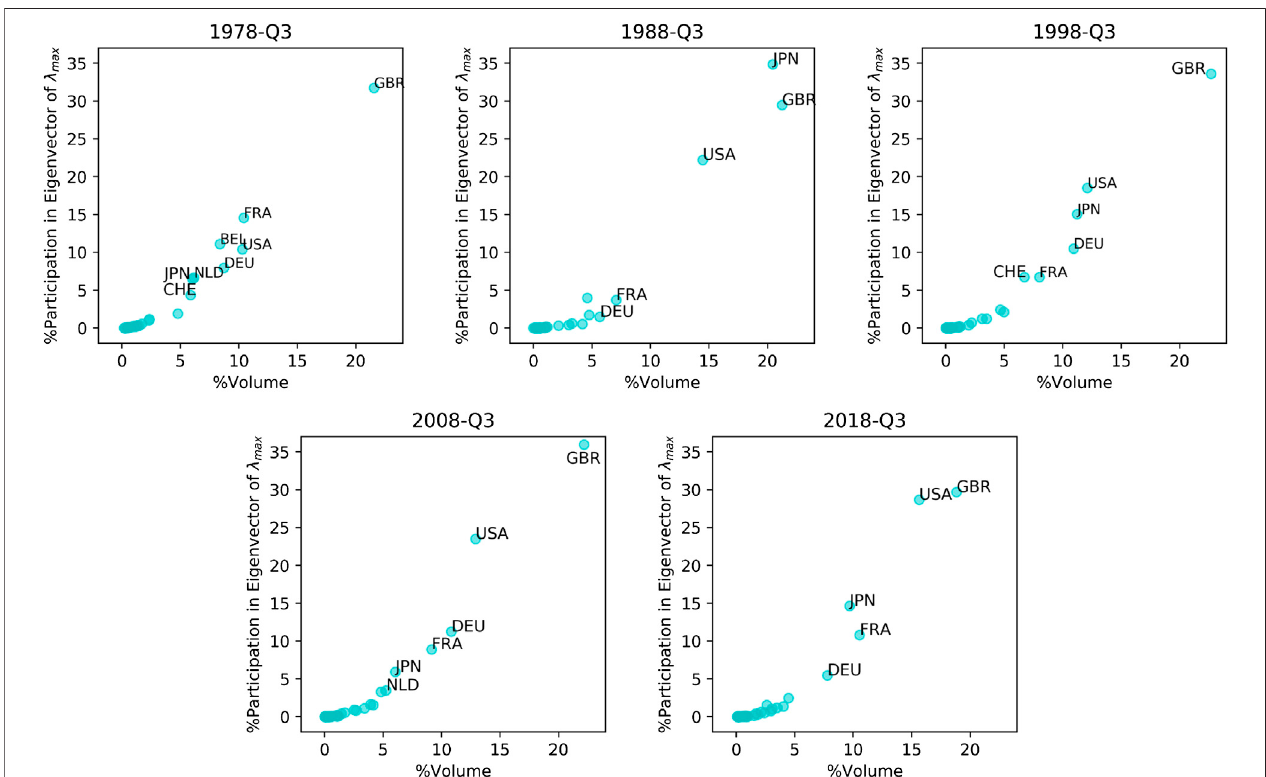
FIGURE 5 | The percentage of the participation of each country in the eigenvector of λ max vs. the percentage of the transaction of each country from the total transaction ( % volume j / (cid:6) N i Volume i ) . (Note: Countries possessing more than 5% of total volume are annotated by